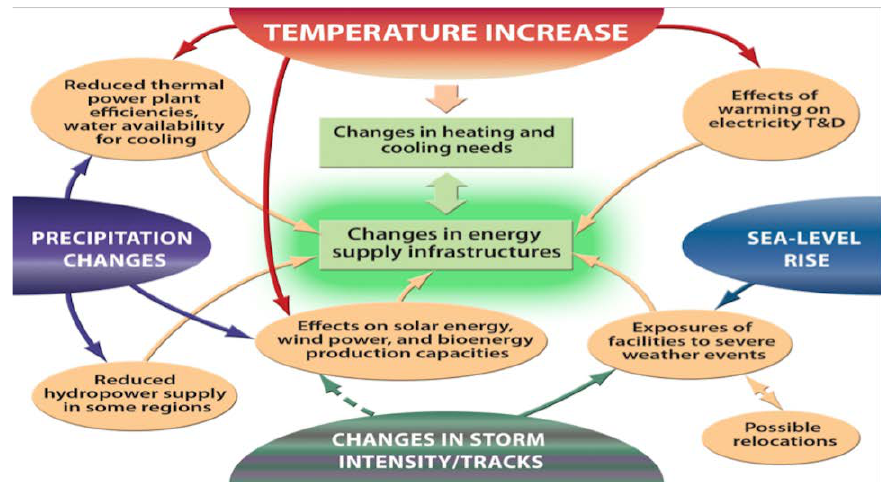
Figure 2. Global warming influence on the energy sector (source: [34]).